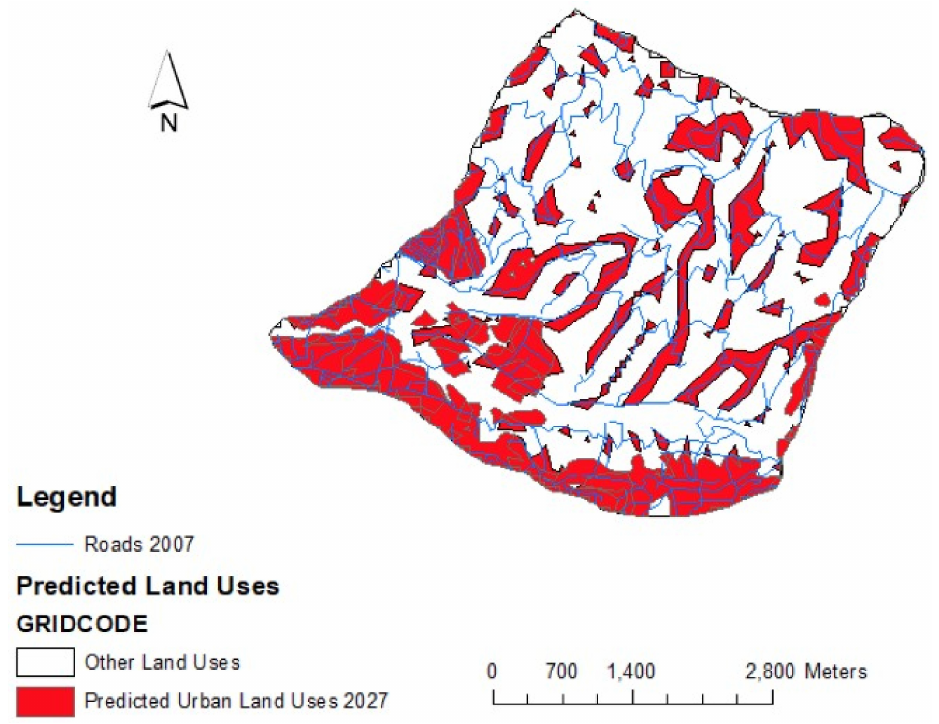
Figure 5. Predicted land use for the year